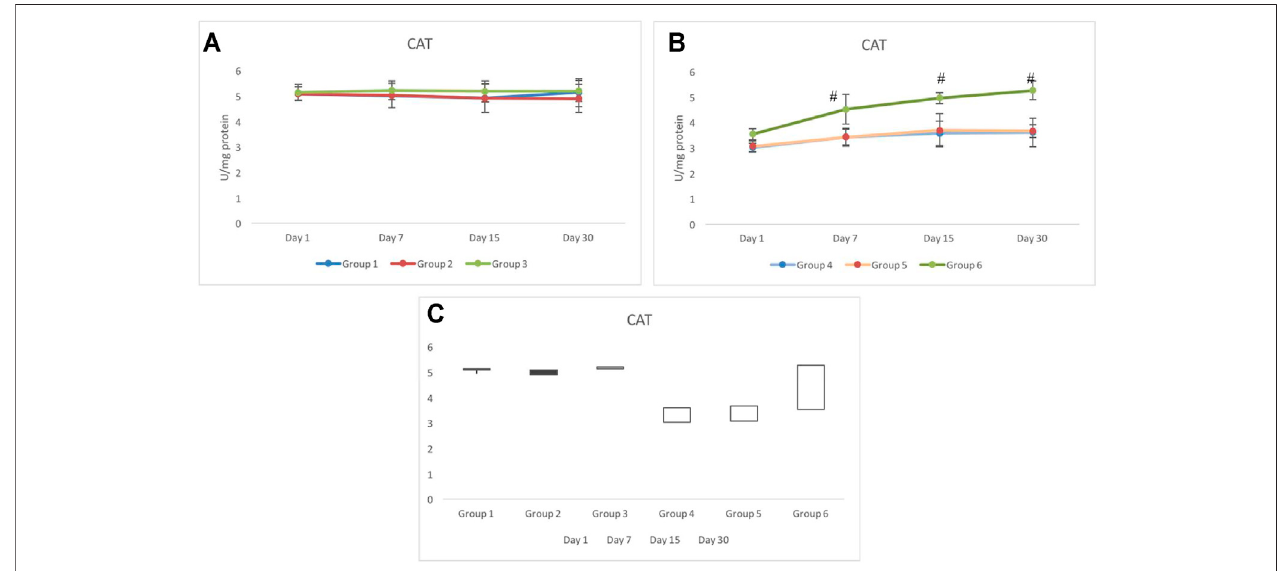
FIGURE 8 | Response of catalase (CAT) in pretreated CRE/CRE-AgNP – treated non-exposed (A) and exposed (B) animals. Groups indicating the gain/loss in activity ofcatalase (C) during the durationofinvestigation. * p < 0.05signi fi cance levelwasmeasured against group1. # p < 0.05 signi fi cance level wasmeasuredagainst group